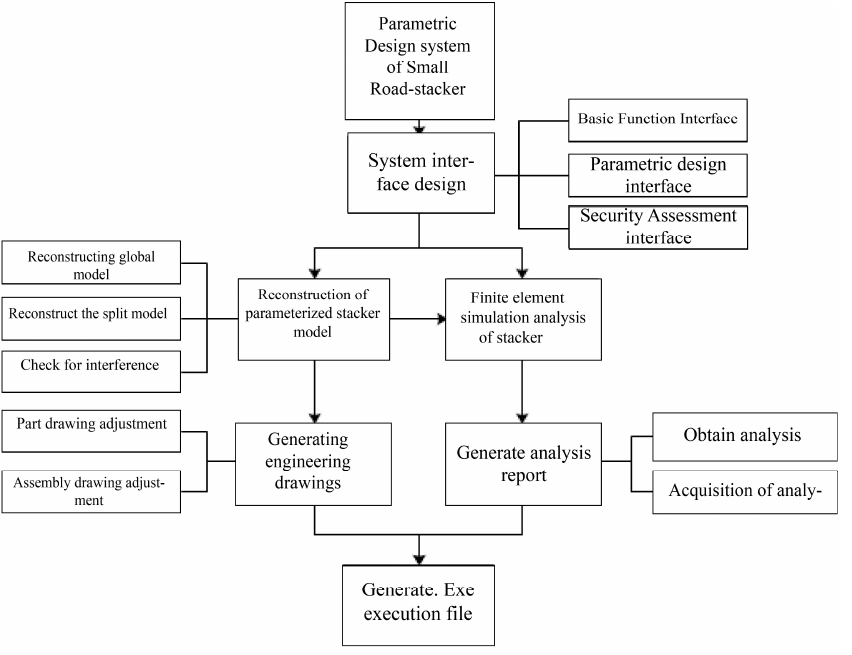
Figure 7. The overall software development plan.